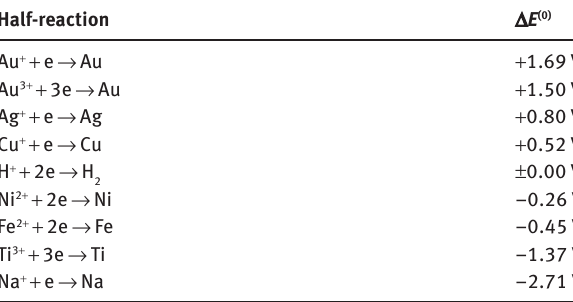
Table 1: Standard potentials for selected half-reactions at 25 ° C referenced to the SHE